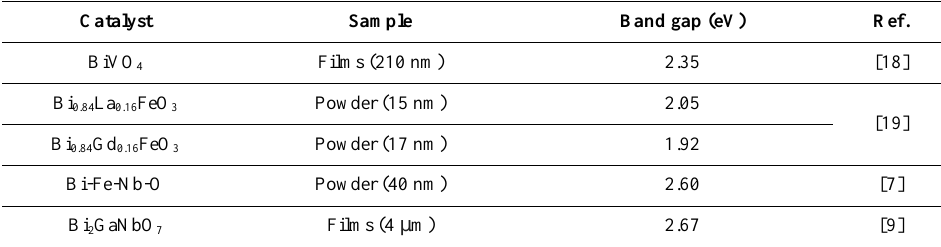
Table 1. Comparison between band gap from this research and